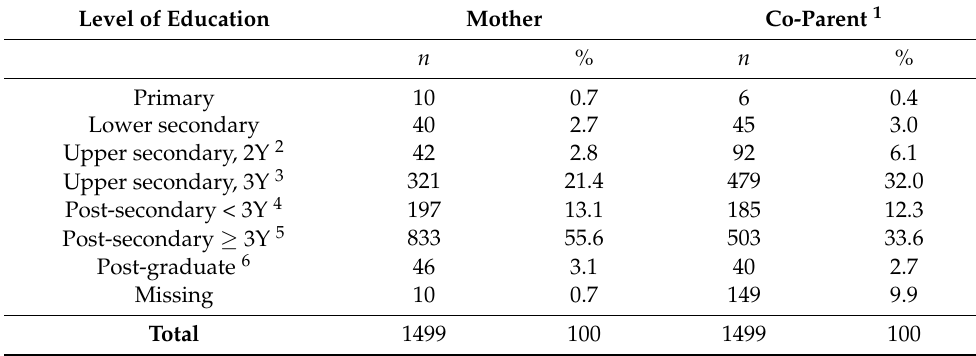
Table 2. Parents’ level of